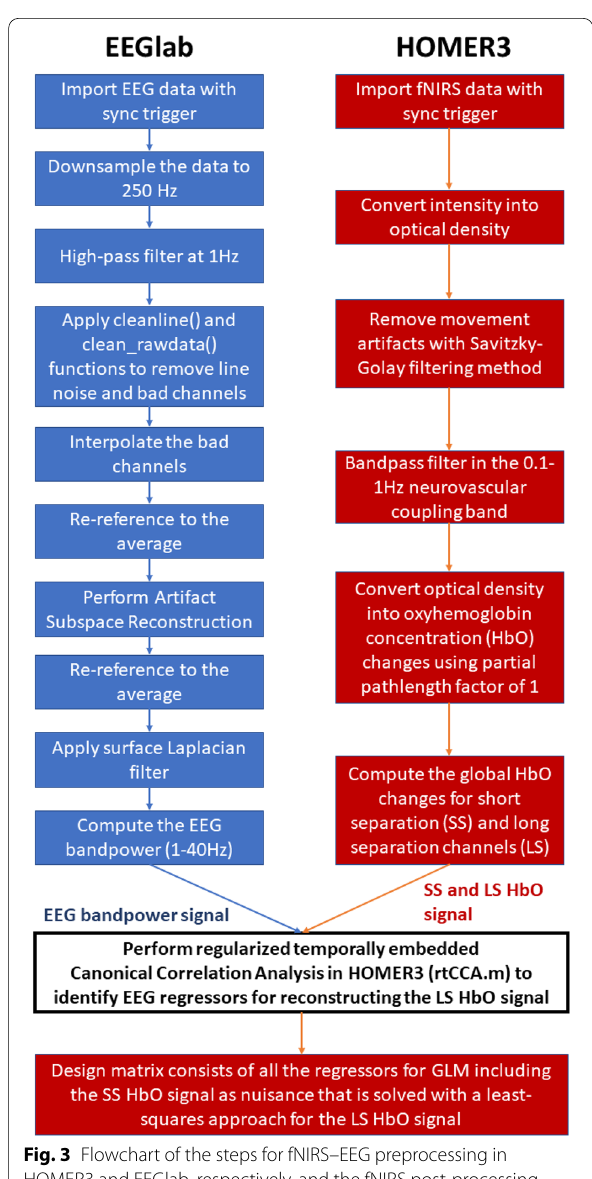
Fig. 3 Flowchart of the steps for fNIRS–EEG preprocessing in HOMER3 and EEGlab, respectively, and the fNIRS post-processing using the EEG regressors and the short-separation HbO regressors in